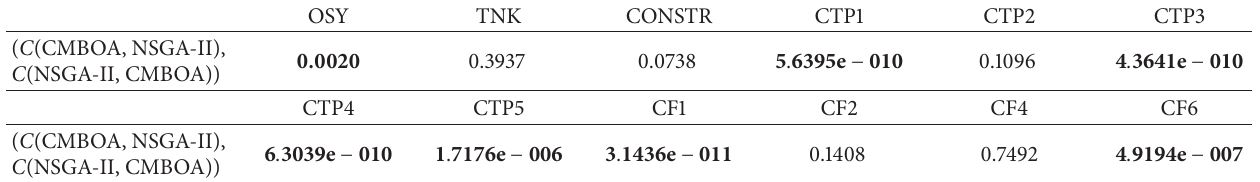
Table 2: Wilcoxon rank-sum test on C value of CMBOA and NSGA-II.